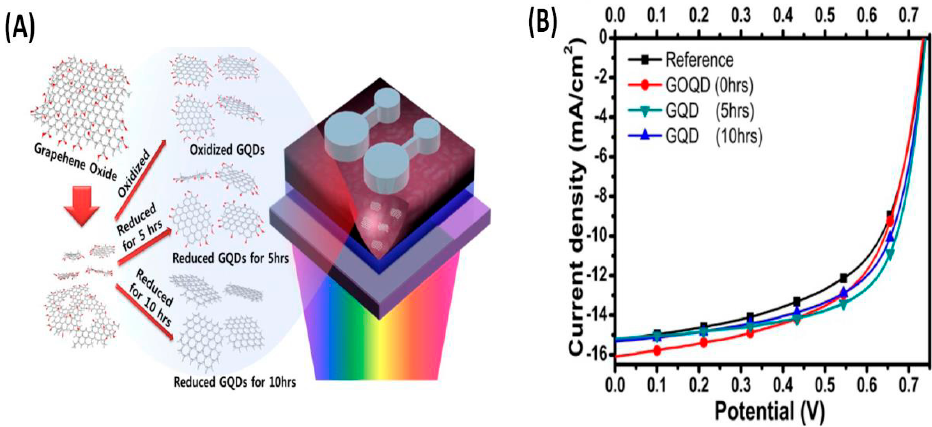
Figure 8. ( A ) Schematic representation of the synthesis of graphene oxide quantum dots (GOQDs) and reduced graphene oxide quantum dots (rGOQDs), where the edge functional groups are controlled by adjusting the thermal reduction time. ( B ) J–V curves of the PSCs with different types of GQDs. Reproduced with permission from Ref. [69].